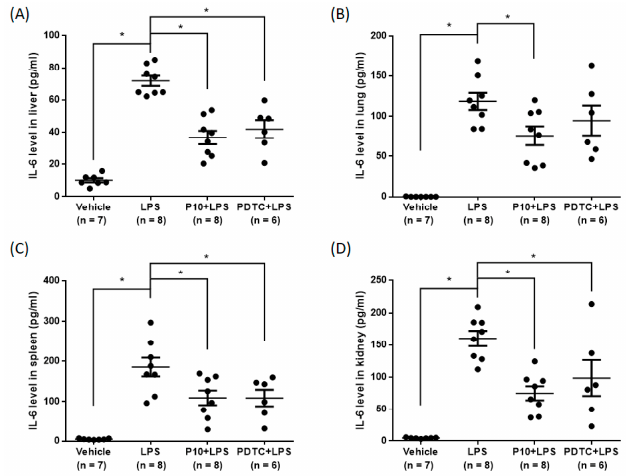
Figure 7. Pilloin decreases tissue IL-6 levels in LPS-induced septic mice. Pilloin decreases the levels of IL-6 in the liver ( A ), lung ( B ), spleen ( C ) and kidney ( D ) of LPS-treated mice. Experimental scheme is described in Figure 6A, and data were collected from mice exposed to various treatments for 12 h after LPS challenge. The production of IL-6 was determined by ELISA. The values were shown as mean ± SEM. * indicates statistically significant ( p <